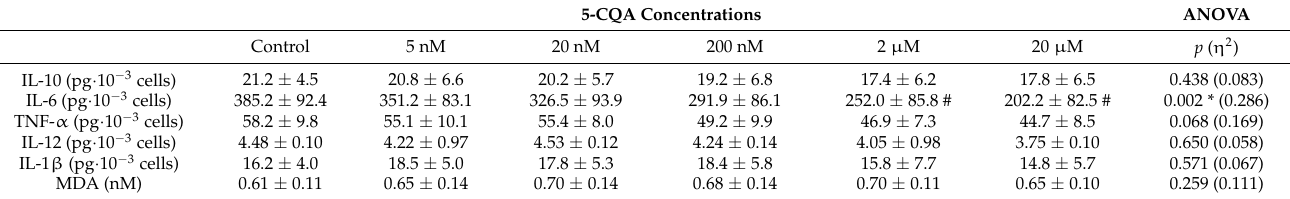
Table 3. Effects of 5-CQA on LPS-stimulated cytokine production and MDA